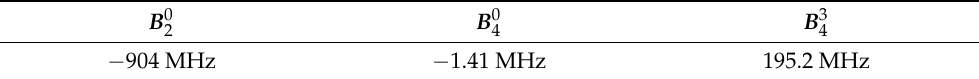
Table 1. The spin-Hamiltonian parameters of zero-field splitting for Mn 2+ ions in TCP. B 0 2